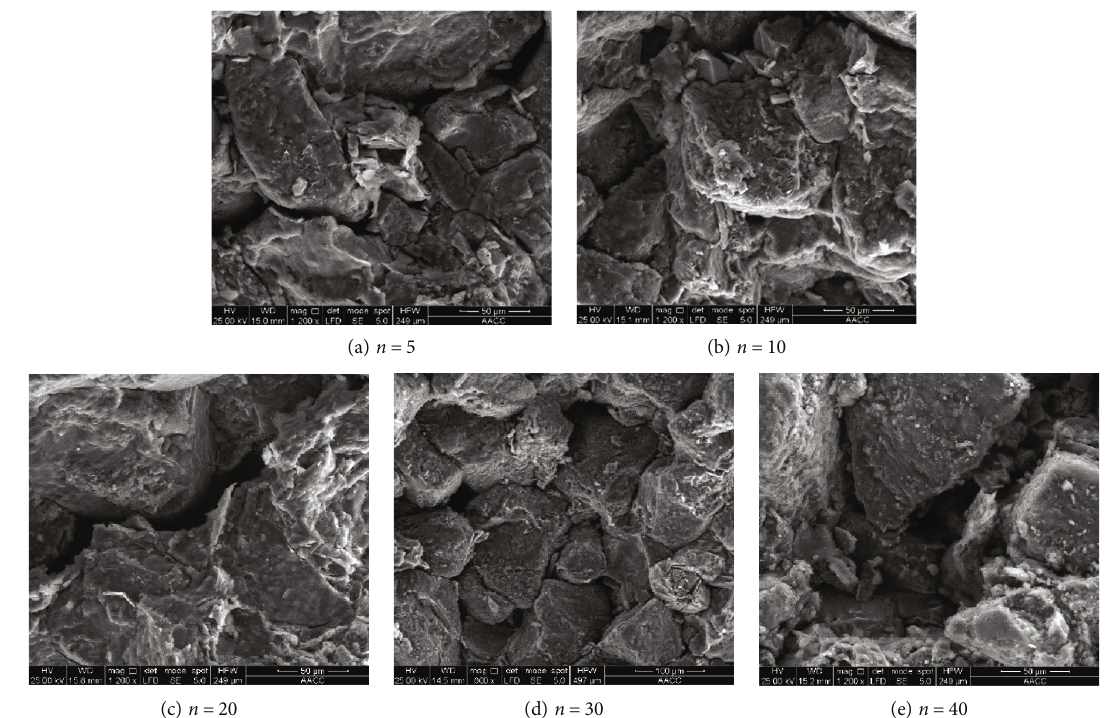
Figure 9: SEM images of micromorphology when pH = 2 : 5